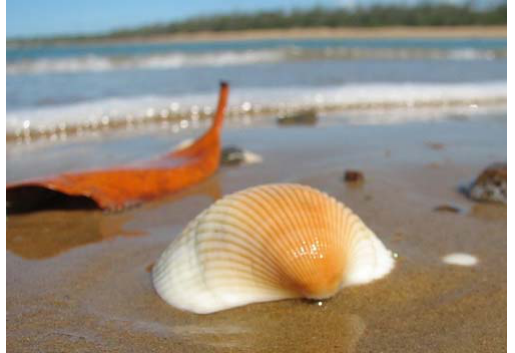
Figure 7: ‘Shell on the Beach’ by David de